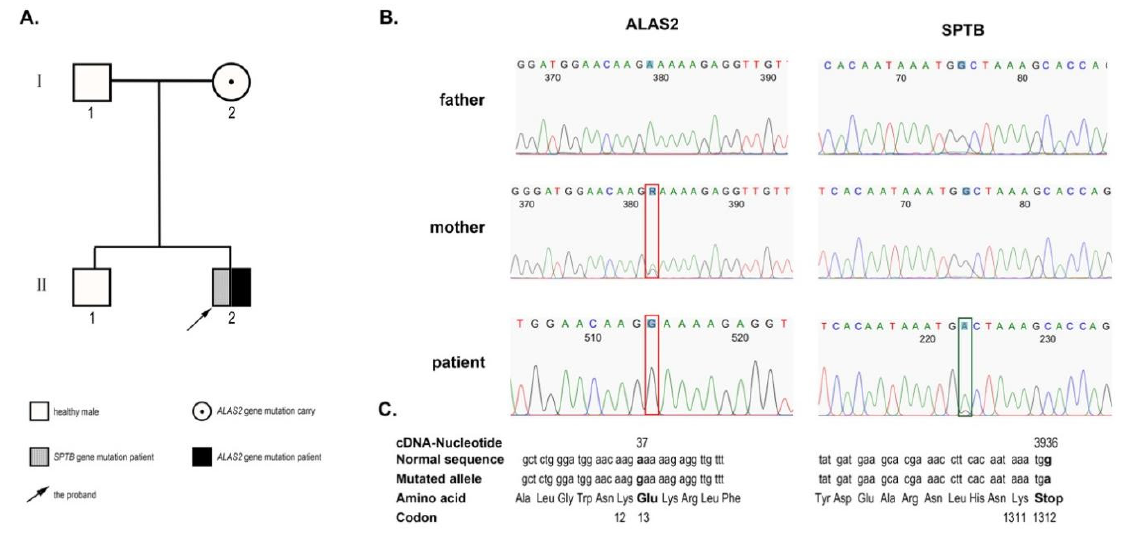
Figure 2. Schematic of the inheritance pattern in the family and the results of NGS. ( A ) Pedigree of the family with hereditary spherocytosis (HS) and X ‐ linked sideroblastic anemia (XLSA). ( B ) The patient harbors a heterozygous mutation c.3936G > A in the SPTB gene and a hemizygous mutation c.37A > G in the ALAS2 gene identified by NGS. The mutation of ALAS2 is inherited from his asymptomatic heterozygous mother, and the mutation of SPTB may be a de novo monoallelic variant. ( C ) ALAS2 mutation results in amino acid switching (p.K13E), and SPTB mutation led to the formation of truncated β‐ spectrin (p.W1312X).